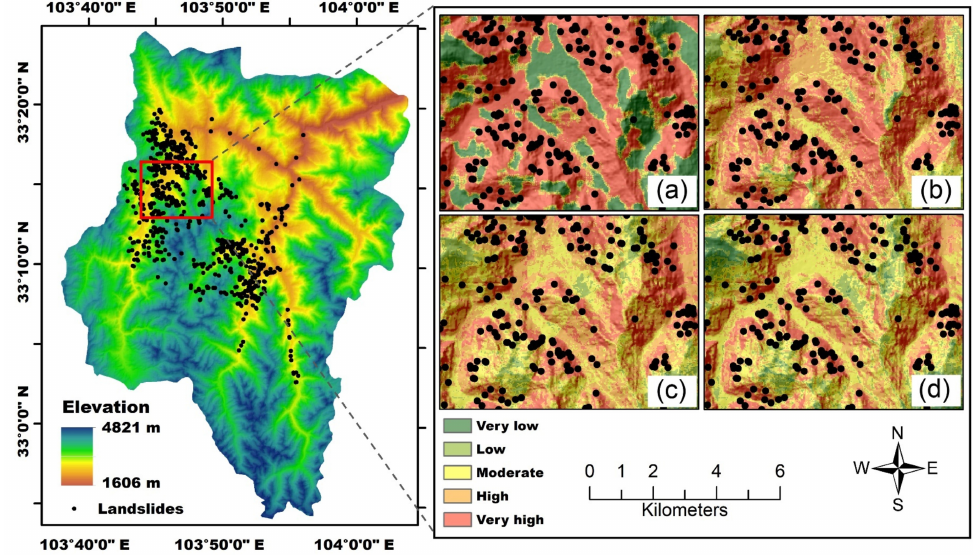
Figure 15. Local magnification of Figure 10 ( a – d ): landslide susceptibility maps using ( a ) convolu- tional neural network, ( b ) random forest, ( c ) logistic regression, and ( d ) support vector